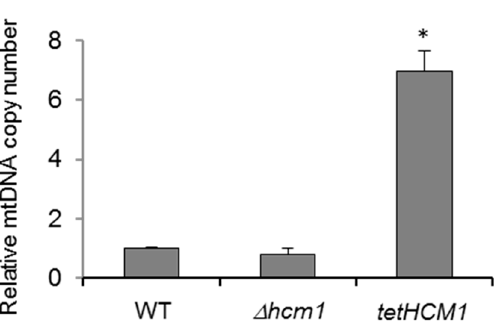
Figure 4. Hcm1 and mtDNA copy number. The number of copies of mtDNA was normalized by the number of copies of nDNA as described in Materials and Methods. COX1 was used as a target mitochondrial gene, and ACT1 was used as the reference nuclear gene. Gene amplification was carried out by real-time qPCR in a duplex reaction from total DNA from the indicated strains. Statistical analysis was performed comparing mutants with WT cells. The data are represented as the means ± SD from at least three independent experiments. * p < 0.01.